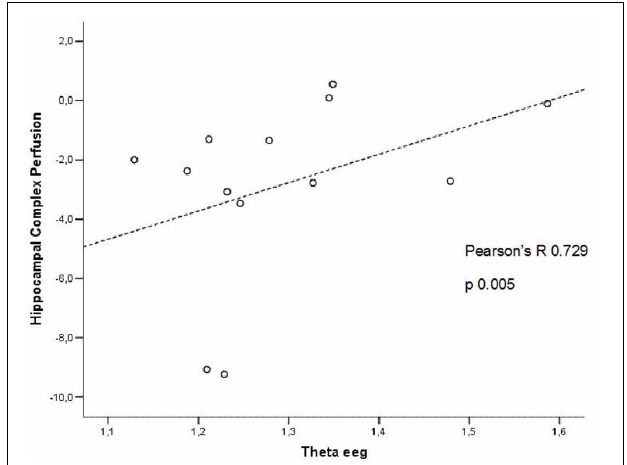
FIGURE 4 | Pearson r correlations between EEG theta rhythm and hippocampal complex perfusion in patients at high risk to develop AD.